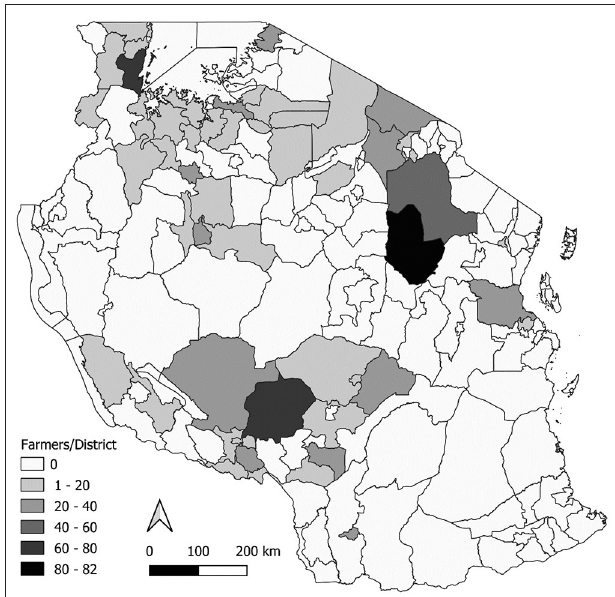
FIGURE 2 | Distribution of interviewed farmers within